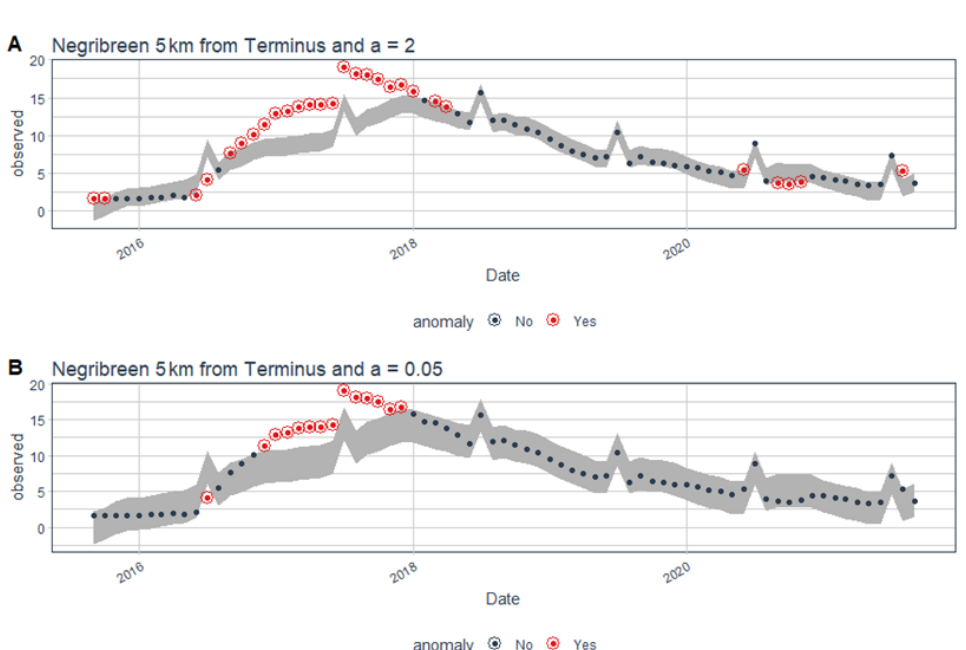
Figure 4. Visualization of how alpha affects the classification on the remainder curve at Negribreen 5 km from terminus. ( A ) shows a high value of 2 (not strict) and ( B ) a = 0.05 (very strict), the latter being used as parameterization in this study.